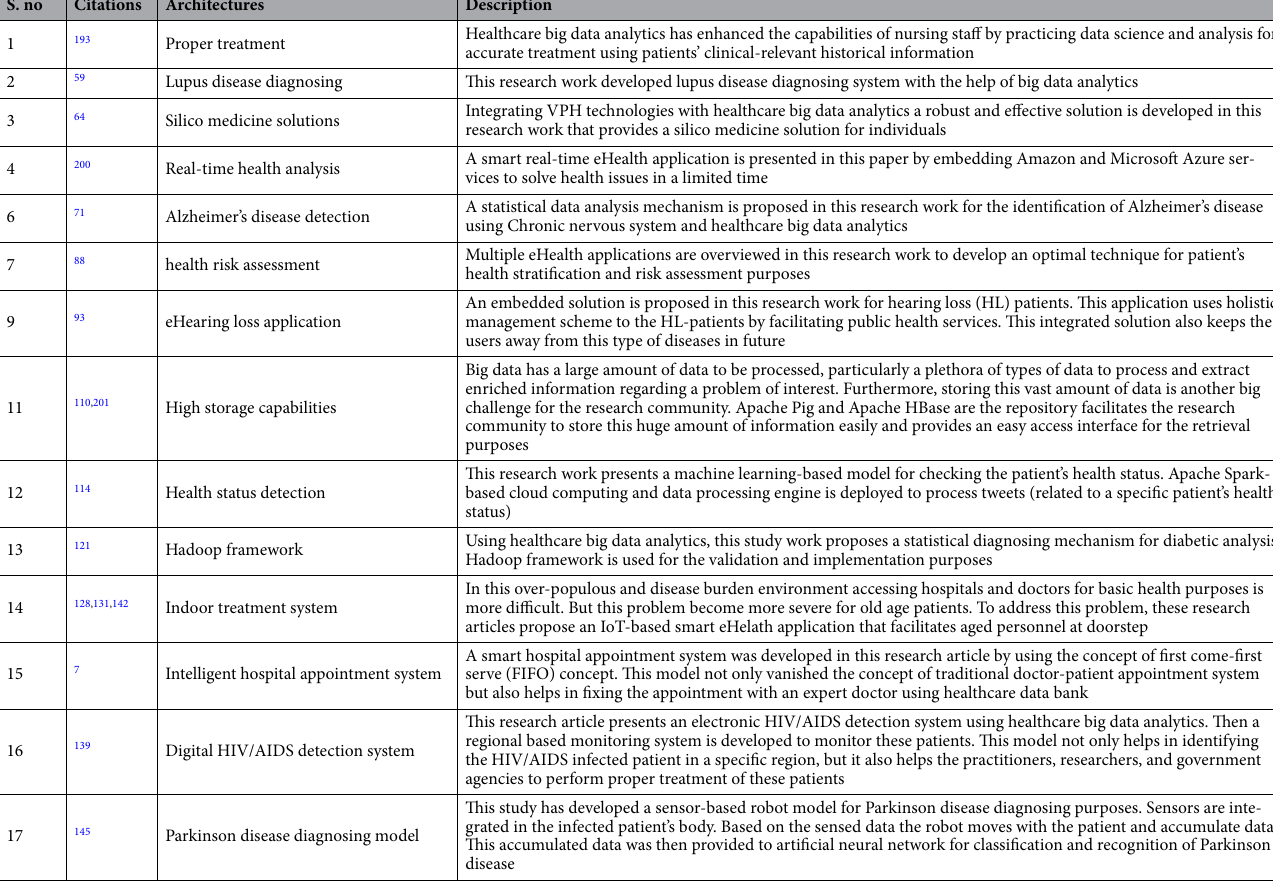
Table 10. Applications of big data analytics in healthcare